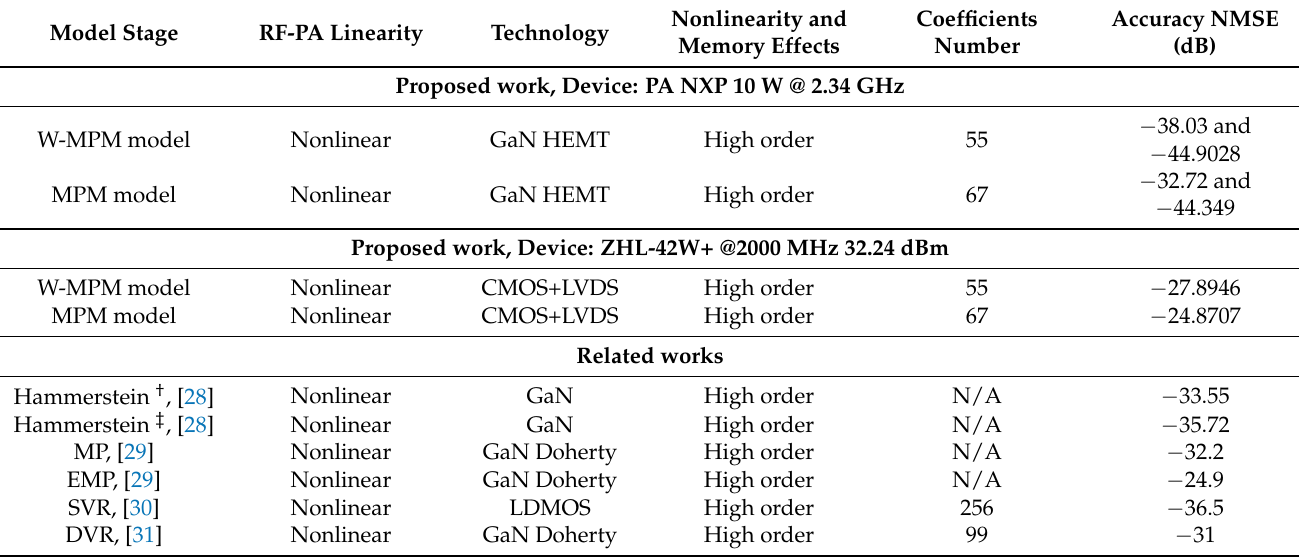
Table 5. Comparison of dynamic W-MPM for RF-PA modeling versus related work.